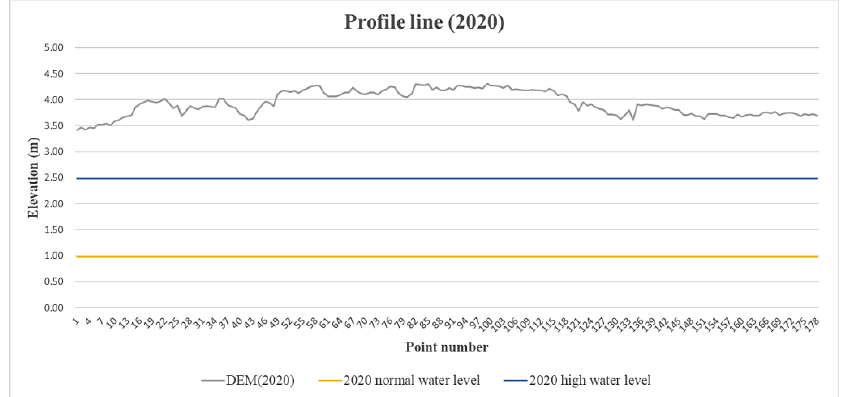
Figure 24. Static display of dam profile and sea-level in 2020. The profile line is along the center line of Asphalt Road on dam crest, and the horizontal line is the height of two simulated sea-levels; the highest sea-level is 2.48 m and the normal sea-level is 0.98 m. This is an indication of the submerged range from the perspective of the longitudinal section.